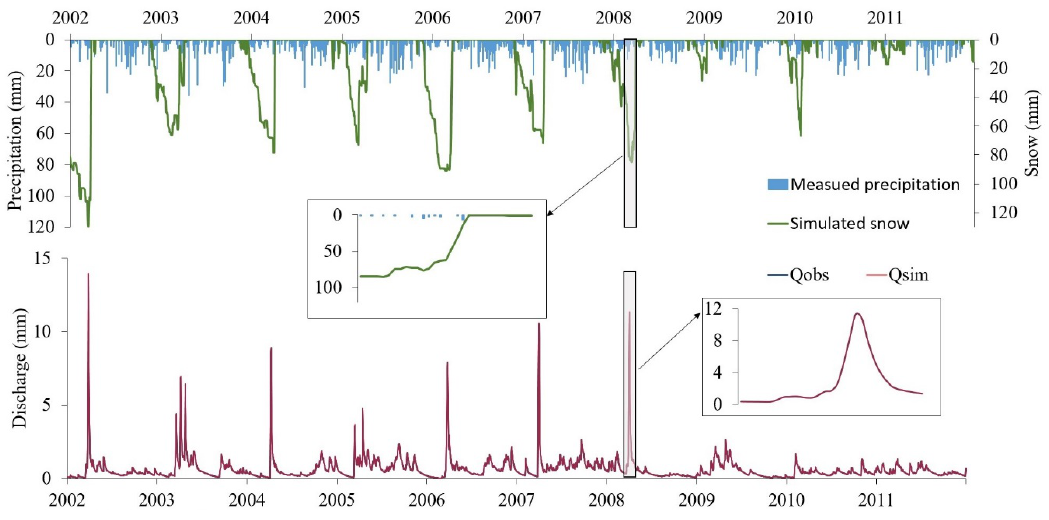
Figure 7. Validation period 1 January 2002 to 31 December 2011, validated with GLM. Table 7. Validation results 1 of the HBV-Land model for the period 1 October 2001 to 31 December 2011. Model E ffi ciency